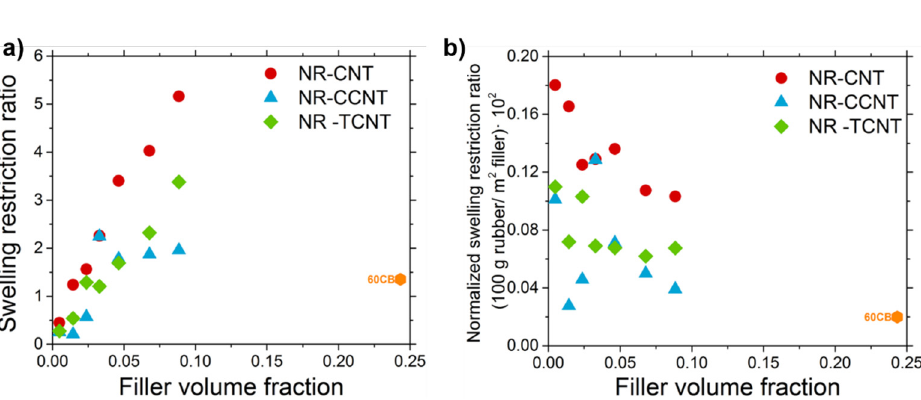
Figure 21. ( a ) Swelling restriction ratio and ( b ) normalized swelling restriction ratio for the studied